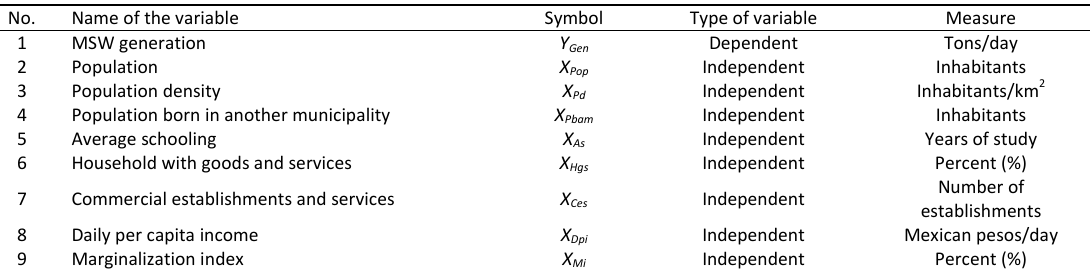
Table 1: Description of variables